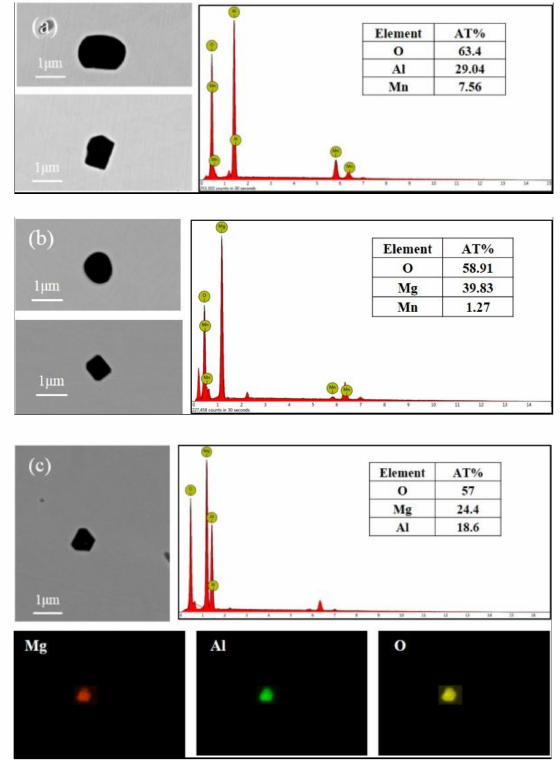
Figure 3. Typical oxide inclusions in steels: ( a ) Al 2 O 3; ( b ) MgO; ( c ) MgO-Al 2 O